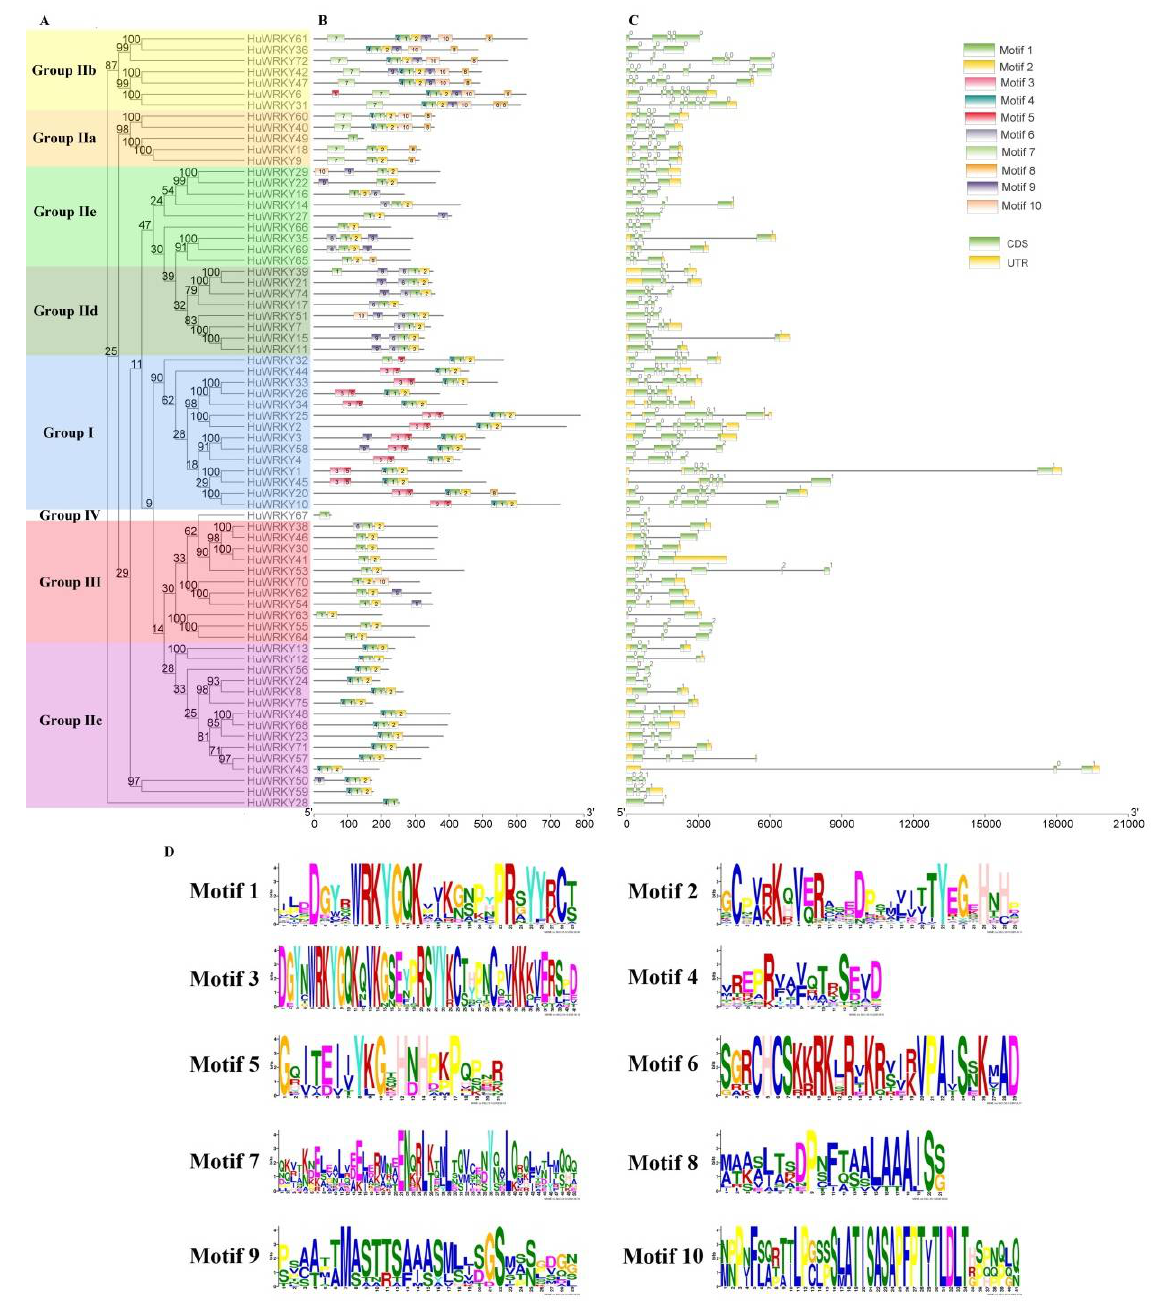
Figure 2. Phylogenetic relationship, gene structure, and conserved motif analysis of HuWRKY genes. ( A ) The NJ phylogenetic tree was constructed with MEGA7 using amino acid sequences of HuWRKYs, and the bootstrap test replicate was set to 1000 times. ( B ) The motif composition of HuWRKY proteins. Ten motifs were displayed in different colored rectangles. ( C ) Exon-intron structure of 70 HuWRKY genes. Green round rectangles represent exons and black lines of the same length represent introns. The yellow rectangles indicate the UTR region. Numerals such as 0, 1, and 2 represent the number of bases skipped to reach the next codon in CDS. ( D ) The amino acid sequences of 10 motifs of HuWRKY proteins.